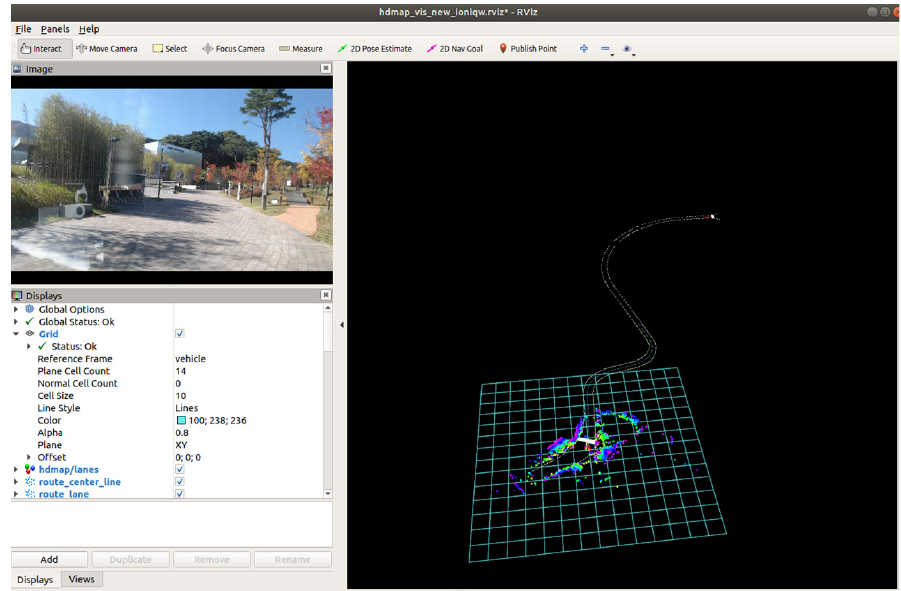
Figure 15. Autonomous Driving System Based on a Precision Road Map Constructed by the Pro- posed System.